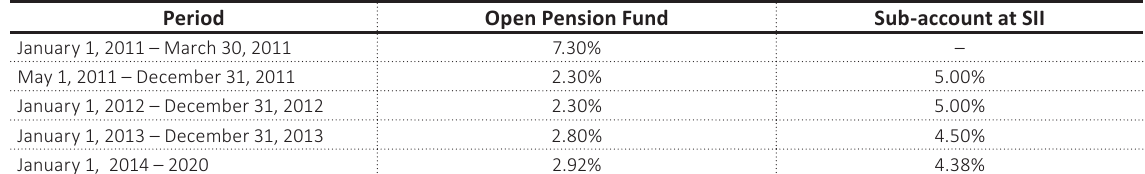
Table 1. Distribution of premium between OPF and sub-account at SII from 2011 Source: Act of March 25, 2011 amending some acts related to the functioning of the social insurance system (Journal of Laws of 2011, No. 75, item 398) and the Act of December 6, 2013 amending certain acts in connection with the definition of rules for the payment of pensions from funds accumulated in open pension funds (Journal of Laws of 2013, item